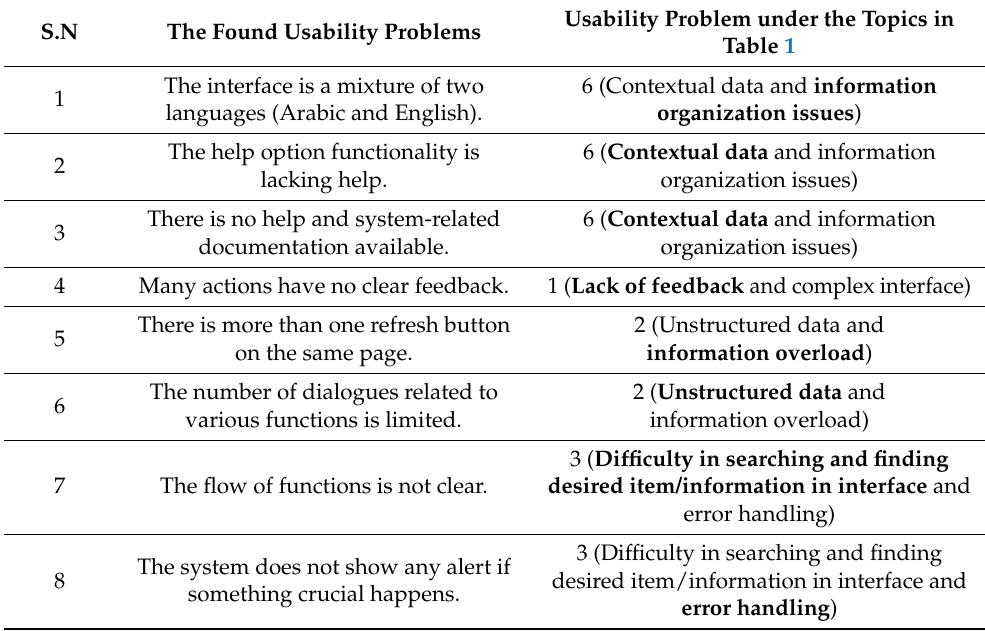
Table 3. The usability problems reported by participants in the heuristic evaluation of ERP systems. S.N